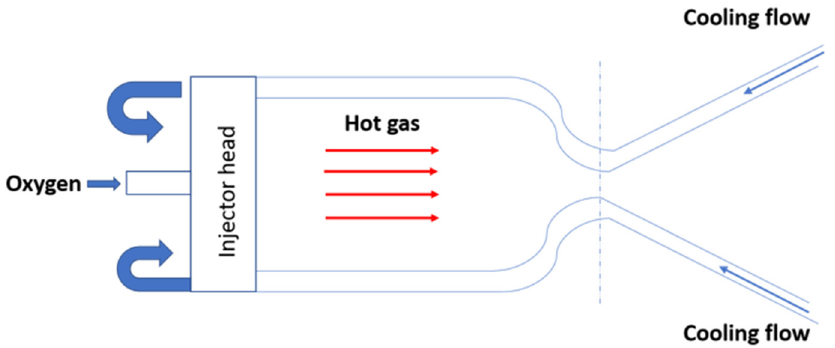
Figure 1. Rocket engine thrust chamber and related functional scheme.